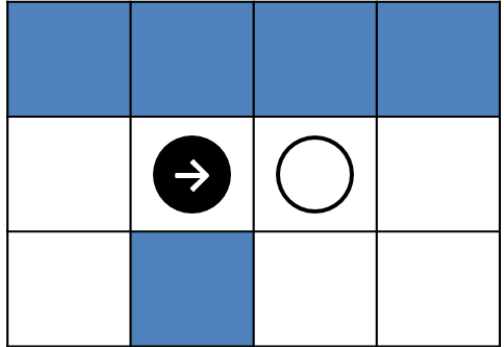
Figure 14. Example of a classified